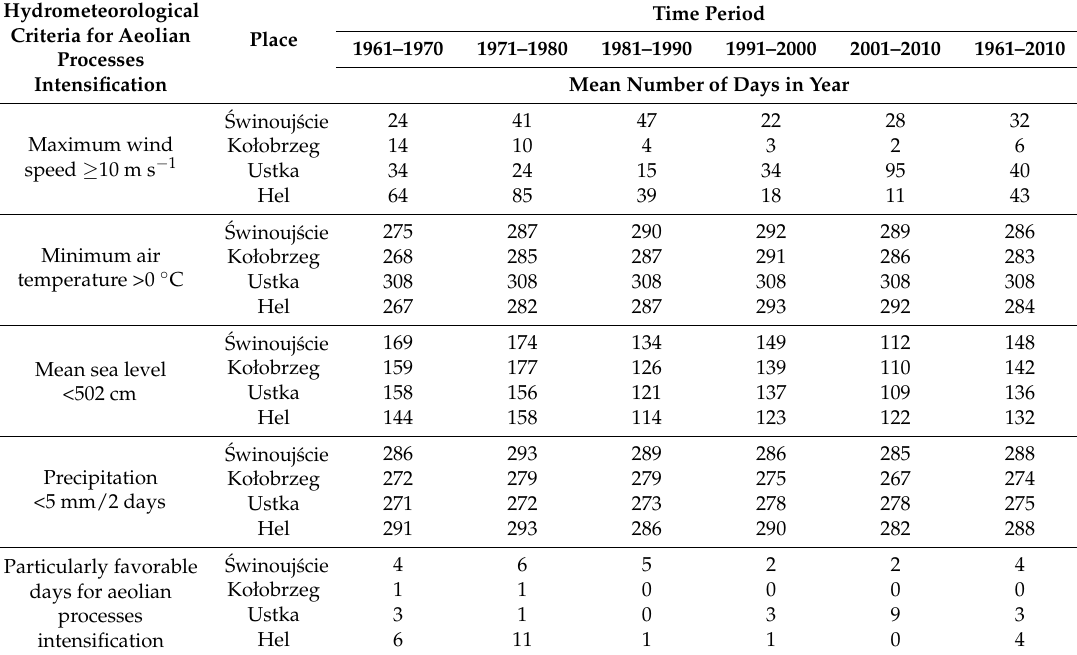
Table 2. Average number of days per year with conditions particularly conducive to intensification of aeolian processes in the Polish Baltic coastal zone.